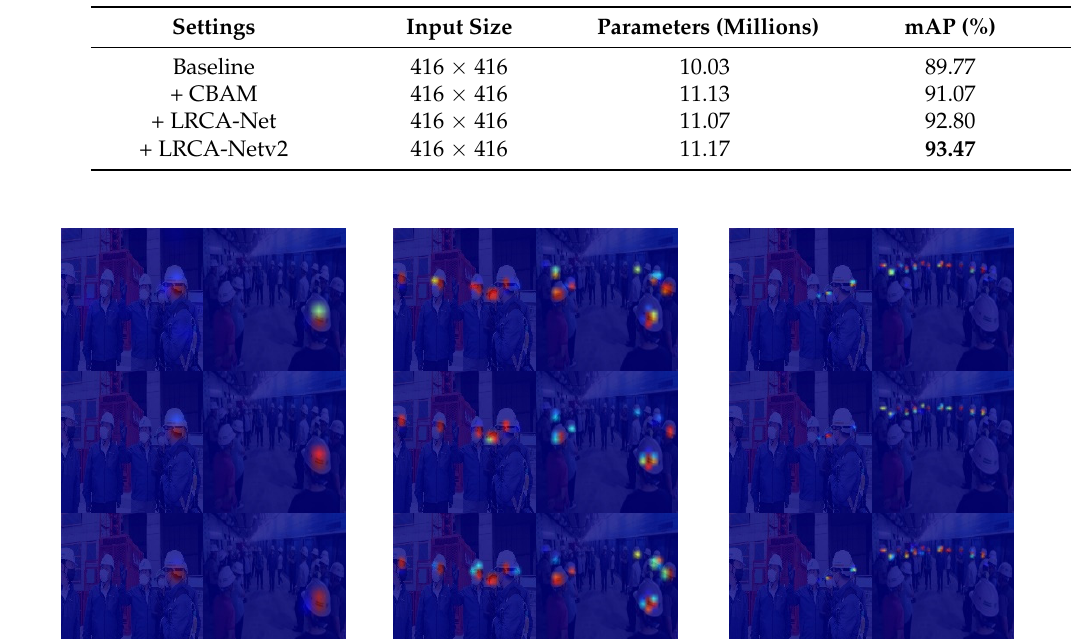
Table 3. Experiments on the ablation of attentional mechanisms using the same data set, where bold numbers indicate the highest mAP and “+” indicates that a certain attention module has been added to the baseline.